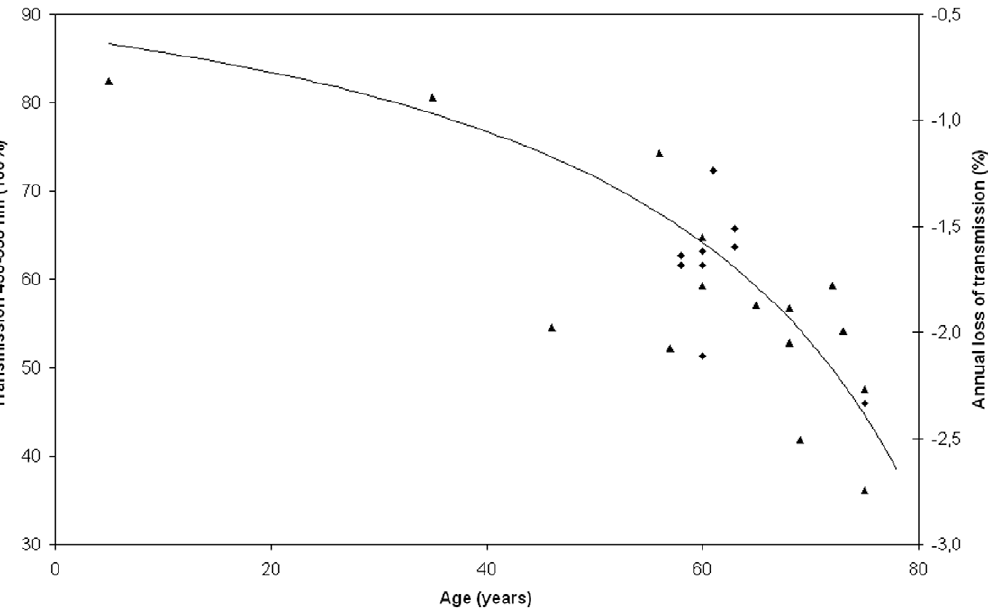
Figure 4. Age-dependent decline in the transmission of blue light. The graph shows the transmission of blue-green light (430–530 nm) measured in vitro in healthy human donor lenses in vitro as a function of age. Diamond markers indicate lenses that were also used in bleaching experiments whereas the triangular marks indicate lenses that were used for transmission measurement only. The left vertical axis shows the transmission from 430 to 530 nm in percent and the right vertical axis show the annual loss of transmission in percent. The curve was drawn based on Eq. 1. doi:10.1371/journal.pone.0009711.g004 PLoS ONE |